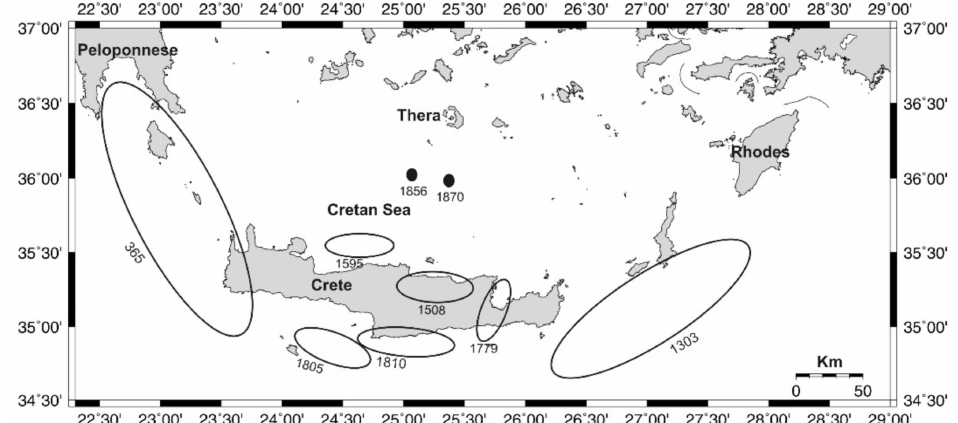
Figure 2. Rupture zones (ellipses) and occurrence years (AD) of the most important historical shallow earthquakes in the Crete area. Ellipses size scales with the estimated earthquake magnitude, M, which ranges from 6.3 ± 0.2 for 1595, to 8.0 ± 0.3 for 1303 and to 8.3 ± 0.3 for 365; M is equivalent to M w . Epicenters of the most important historical intermediate-depth earthquakes are also illustrated as black circles; magnitudes are 7.6 ± 0.3 for 1856 and 6.6 ± 0.3 for 1870. Figure reproduced from